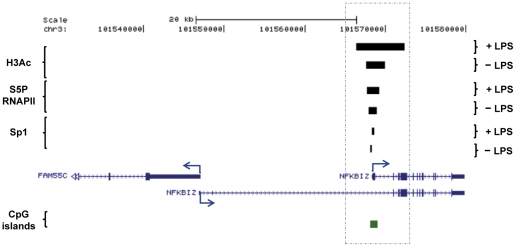
Group 2: Inflammatory up-regulated gene.
NFKBIZ is shown as a representative cytokine gene with an alternative TSS. No H3Ac peaks or CpG islands were identified for the longer transcript. In the promoter area of the shorter transcript, an H3Ac peak is identified, which increases in size upon LPS stimulation. Genes identified by RefSeq using the UCSC browser are shown with blue arrows indicating TSSs locations and directions (GRCh37/hg19).